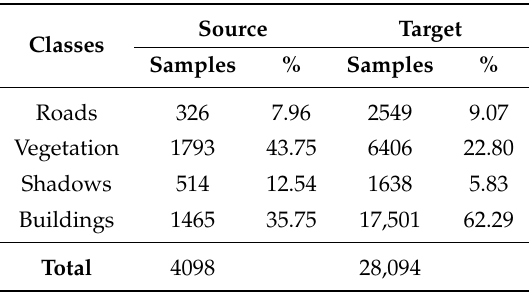
Table 3. Samples available in the Pavia City dataset.